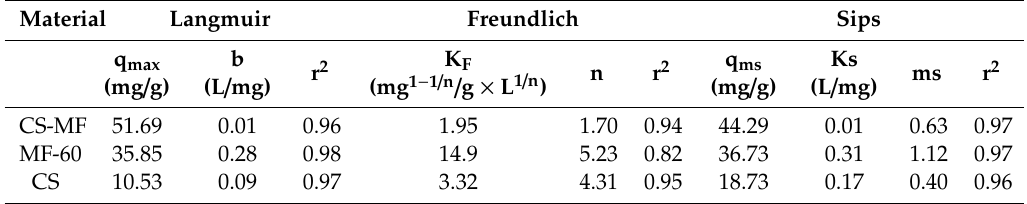
Table 2. Langmuir, Freundlich, and Sips constants of CS-MF, MF-60, and CS.